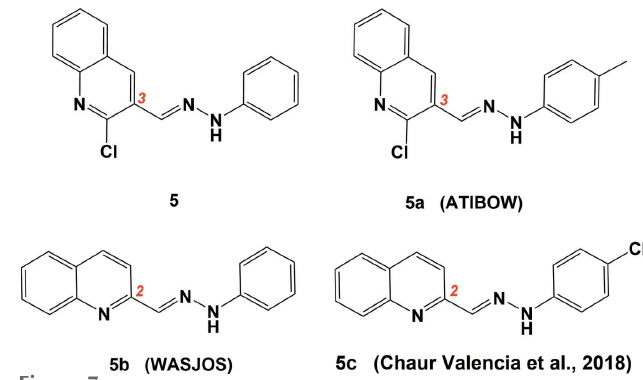
Figure 7 Structures of some related quinoline-hydrazine compounds.